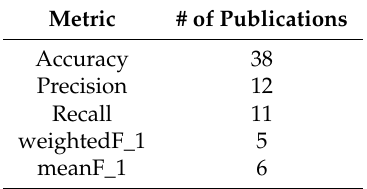
Table 13. Number of publications using these metrics as performance metric for